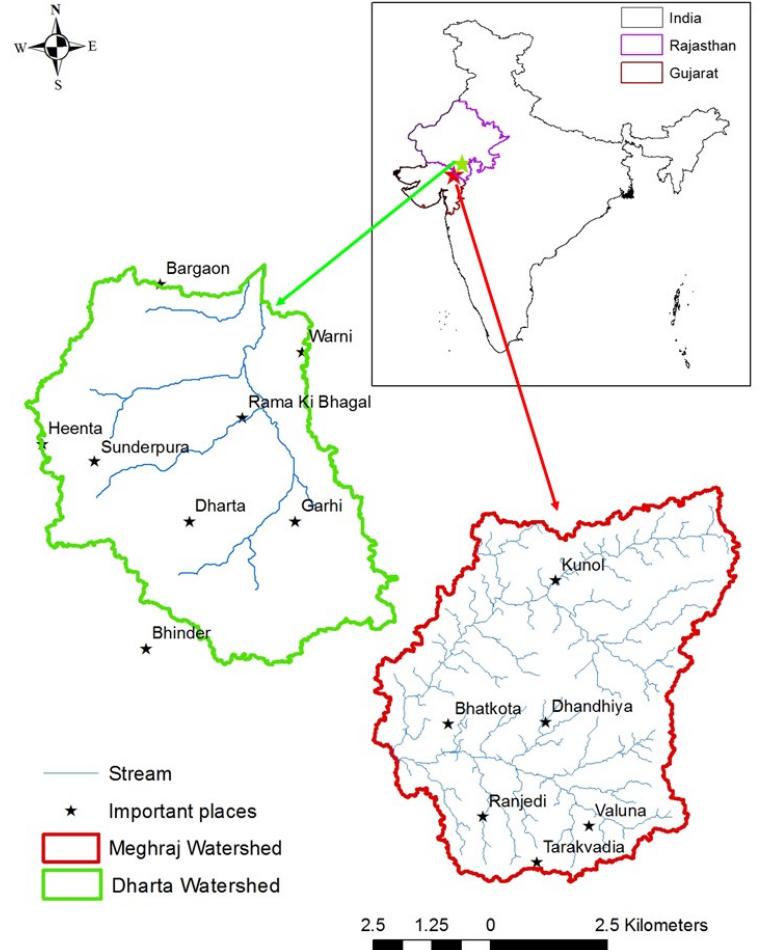
Figure 1. The Meghraj and Dharta watersheds. The inset map shows the location of the watersheds in the states of Gujarat and Rajasthan in